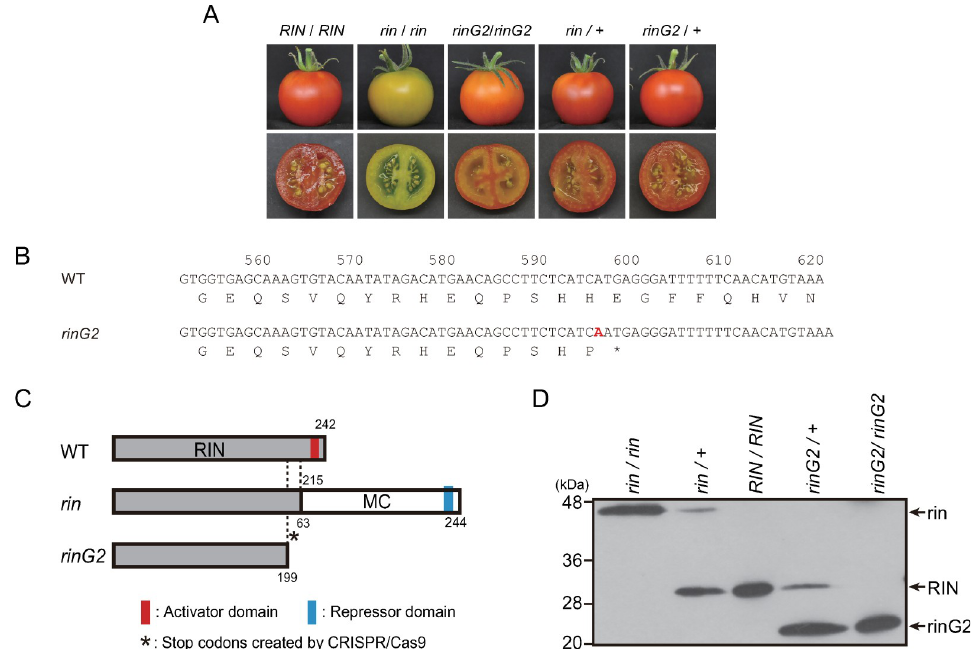
Fig 1. Expression of the rinG2 allele in tomato. A. Ripe fruits with homozygous or heterozygous mutant alleles in the rin locus. Fruits with the indicated genotypes were harvested at 7 days after the breaker stage. B. The rinG2 mutation generates an early stop codon. “A” in red represents the base inserted by genome editing. C. Schematic diagrams of the proteins encoded by the rin and rinG2 alleles. The rin allele produces a protein encoded by a fusion mRNA composed of RIN lacking the last exon and MC lacking the first exon [9]. The rinG2 mutation generates an early stop codon, which removes the C-terminus including the transcriptional activator domain of RIN [23]. D. Accumulation of mutant proteins in heterozygous fruits. In rin- and rinG2- heterozygous fruits, the mutant proteins (indicated as rin and rinG2, respectively) accumulated simultaneously with wild-type protein (RIN). Proteins from nuclei of fruits harvested at 4 days after the breaker stage were separated and subjected to an immunoblotting assay with RIN-antibodies [15]. We did not measure the detection efficiencies of the allelic proteins in extracts from heterozygous lines, and therefore, we cannot conclusively state whether the differences in signal intensities between the allelic proteins reflect differences in their abundances in the cells.